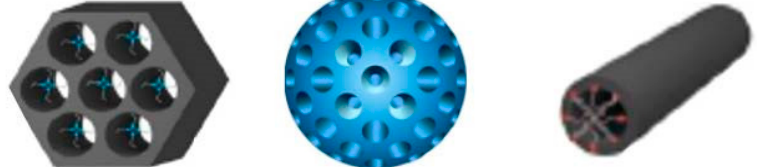
Figure 2. Various morphological models of mesoporous silica.